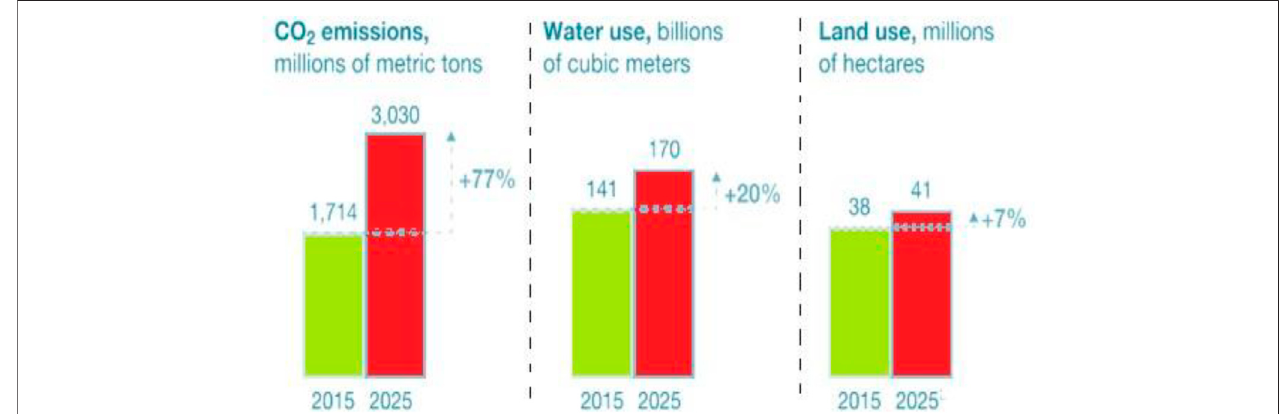
FIGURE 1 | Environmental pollution evaluation.